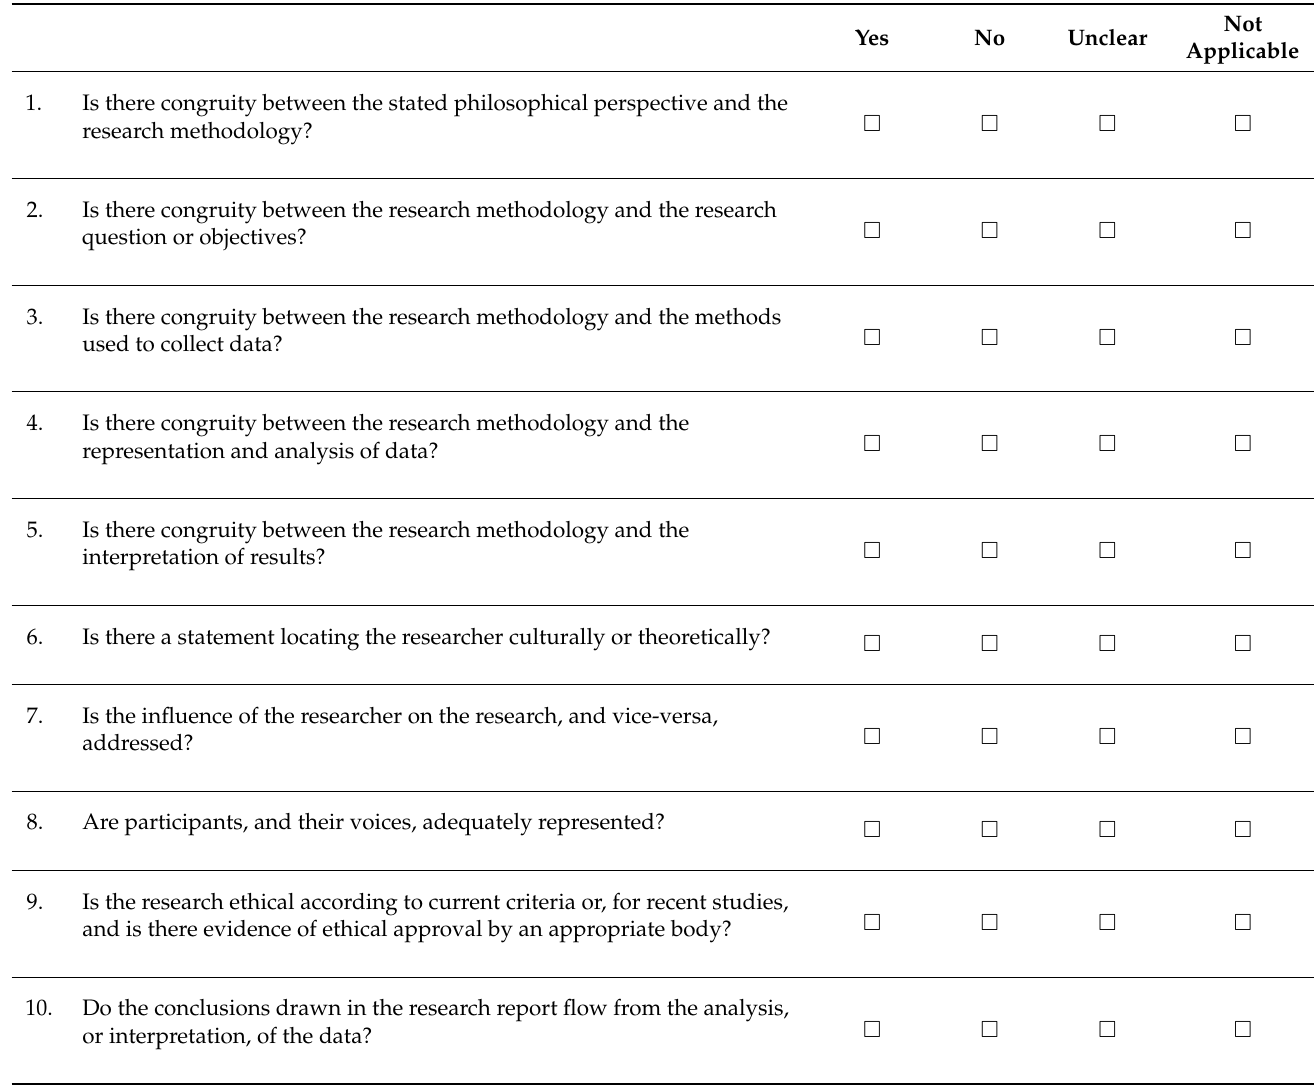
Table A2. JBI Critical Appraisal Checklist for Qualitative